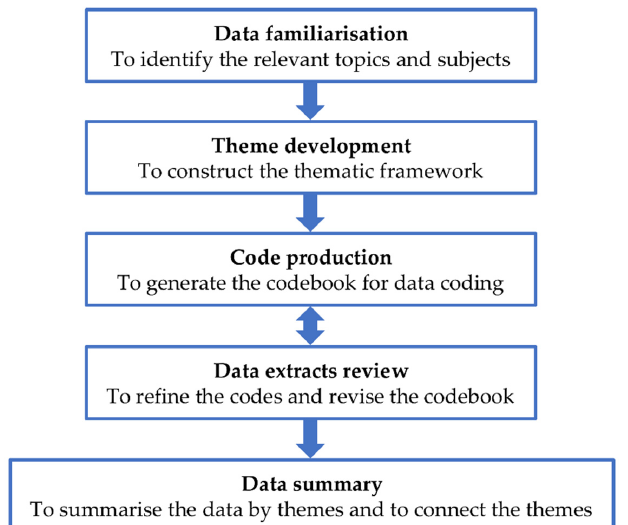
Figure 3. Data-managing process of the individual